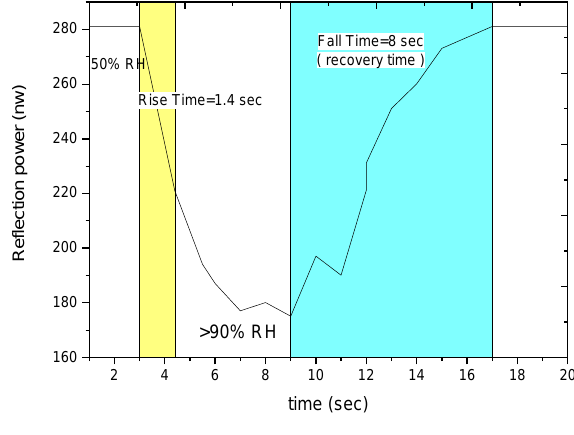
Fig. 9: Response time of the